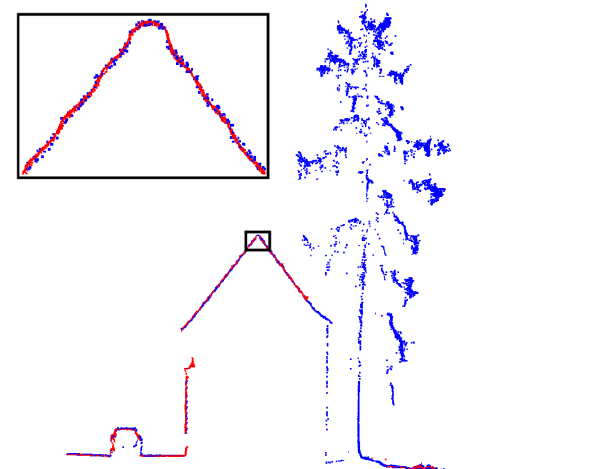
Figure 6. Comparison of a profile through the photogrammetric (red) and LiDAR (blue) point cloud.